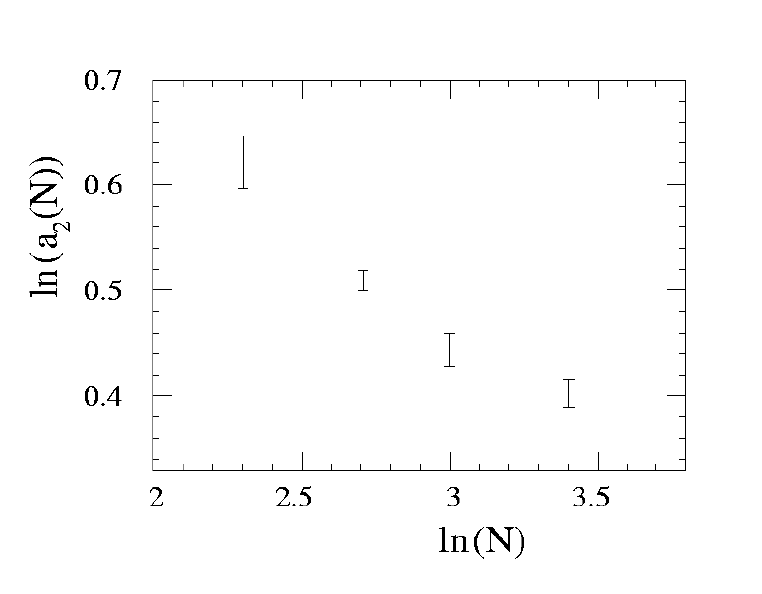
( N ) for polyalanine molecules of length N in a log-log plot. Fig. 2: The parameter a 2